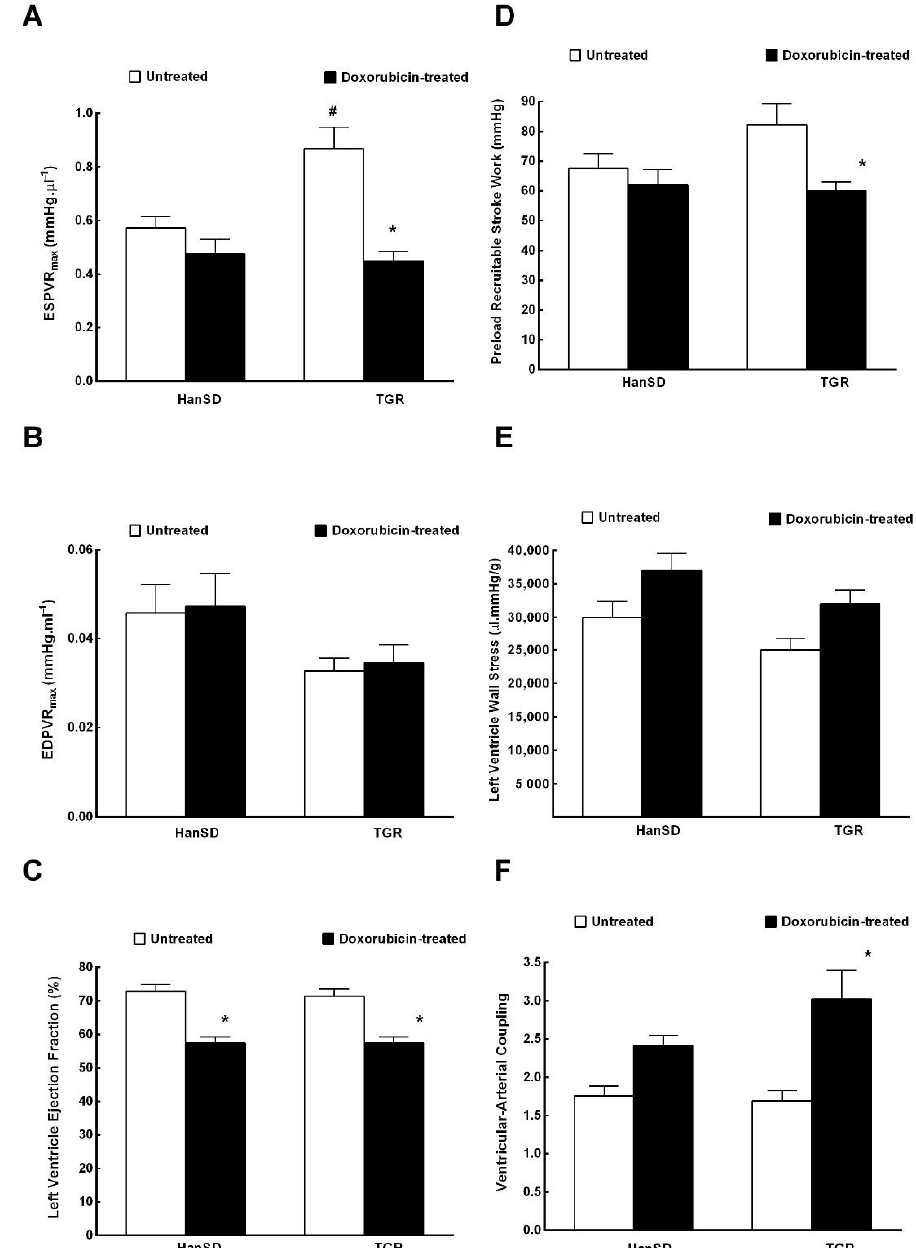
Figure 6. The second part of the data for the left ventricular cardiac function assessment by invasive hemodynamic analysis two weeks after the last doxorubicin injection (i.e., at the end of the experimental protocol) in normotensive, transgene-negative Hannover Sprague-Dawley (HanSD) and hypertensive, Ren-2 transgenic (TGR) rats. End-systolic pressure volume relationship (ESPVR) ( A ), end-diastolic pressure volume relationship (EDPVR) ( B ), left ventricle ejection fraction ( C ), preload recruitable stroke work ( D ), left ventricle wall stress ( E ), ventricular-arterial coupling ( F ). * p < 0.05 compared with untreated animals of the same strain. The values are means ± SEM. # p < 0.05 compared with untreated HanSD